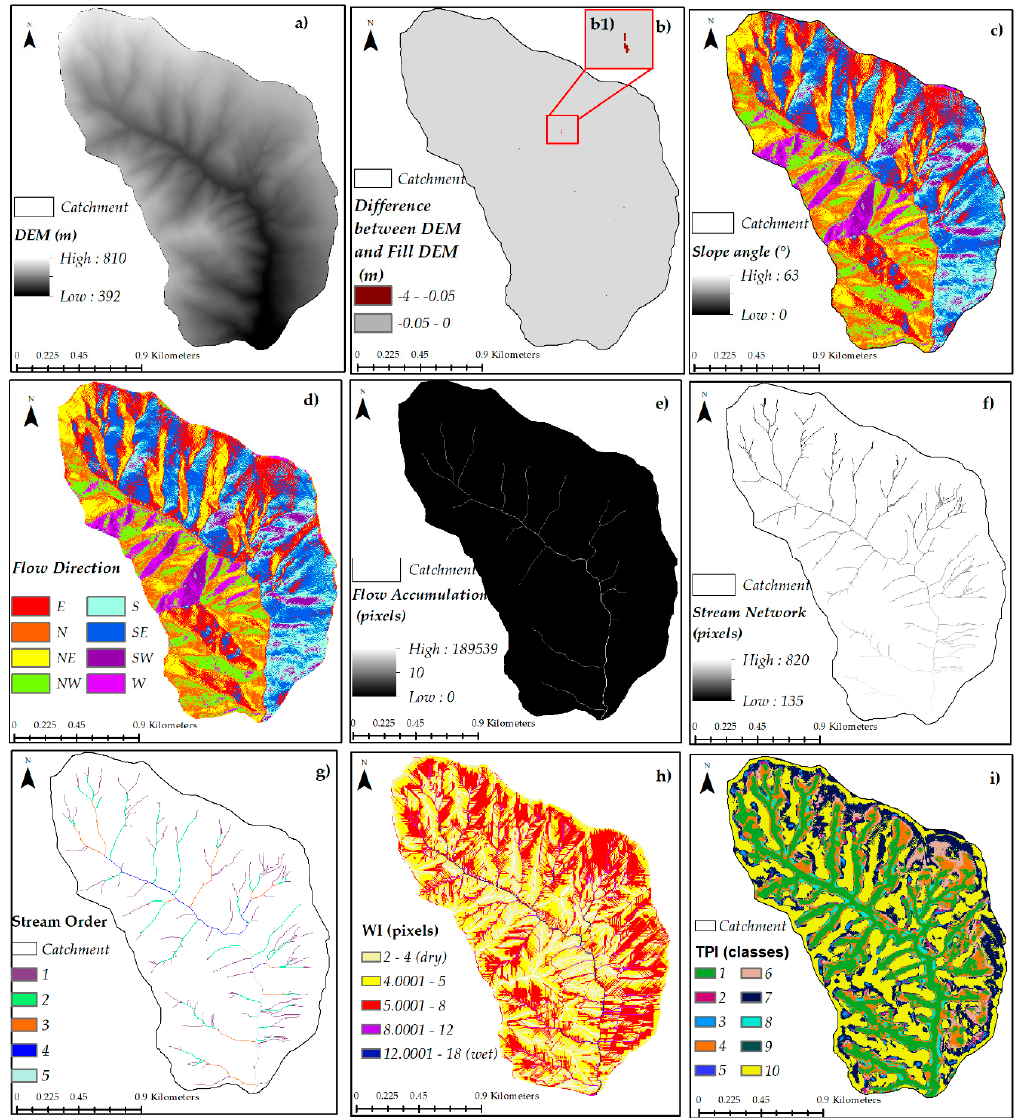
Figure 5. Basic derived maps from the digital elevation model (DEM) with a 5 m cell size. ( a ) Extracted DEM 5 × 5 m; ( b ) Difference map between DEM and Filled DEM; ( c ) Slope; ( d ) Flow direction; ( e ) Flow accumulation; ( f ) Stream network; ( g ) Stream order; ( h ) Wetness Index (WI); and ( i ) Topographic Position Index (TPI) (classes: 1: incised stream; 2: midslope drainages, shallow valley; 3: upland drainages, headwater; 4: U-shaped valley; 5: plains; 6: open slopes; 7: upper slopes, mesas; 8: local ridges/hills in valleys; 9: midslope ridges, small hills in plains; and 10: mountain tops, high ridges).